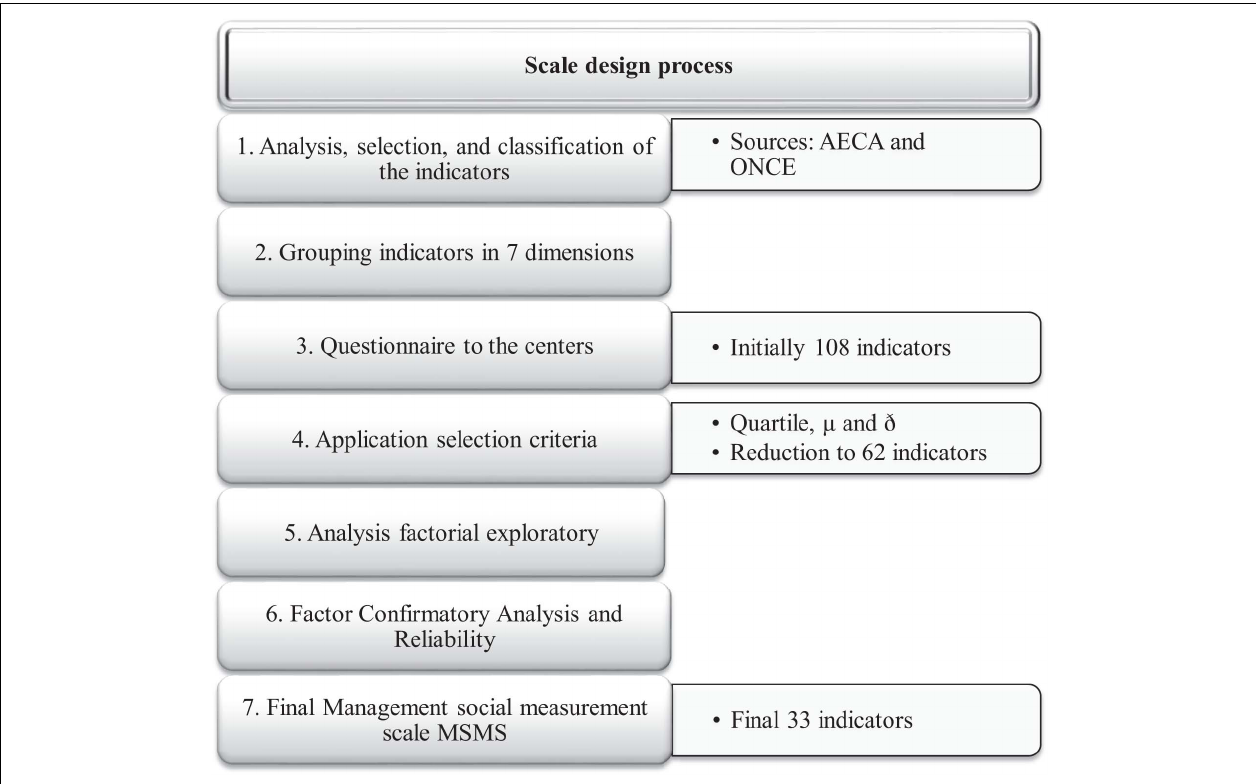
FIGURE 3 | Analysis by centers: use of indicators in the proposed fields. Source: